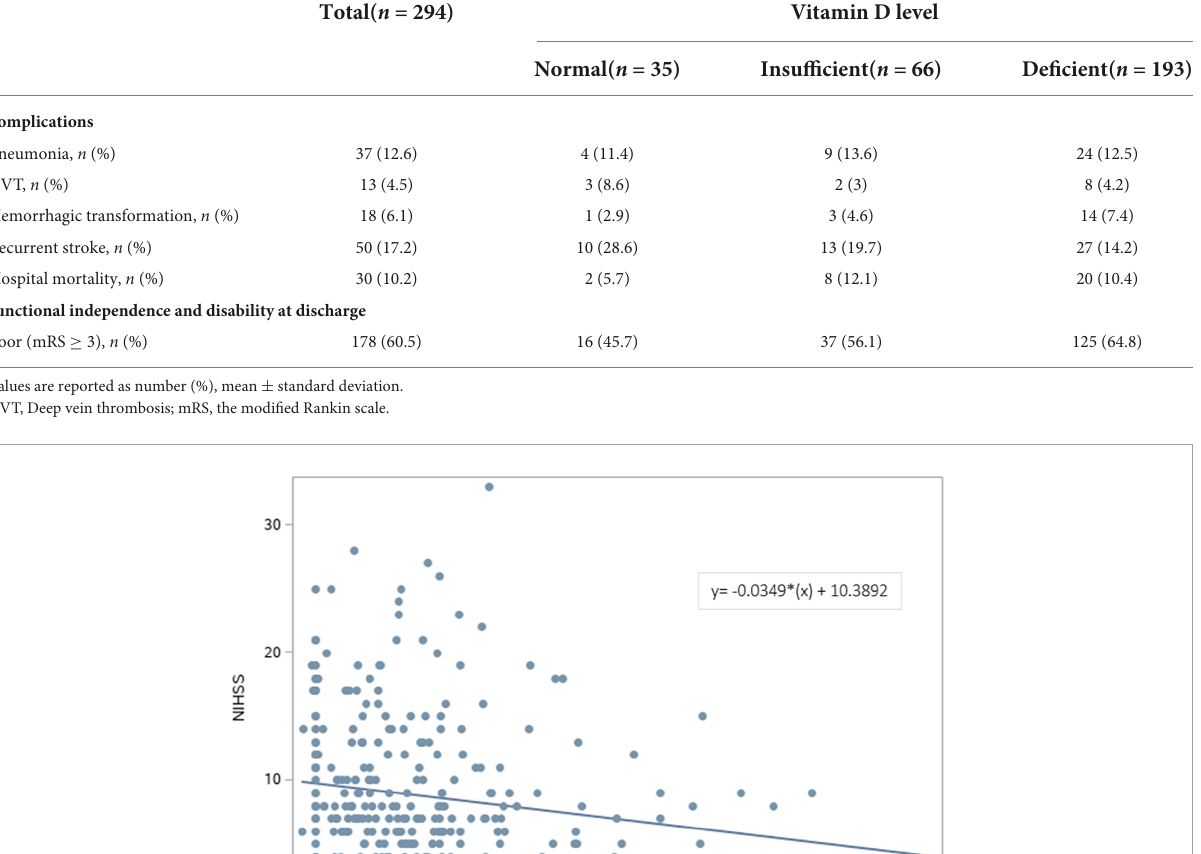
TABLE 2 Complications during hospital stay and functional independence at discharge according to vitamin D level.